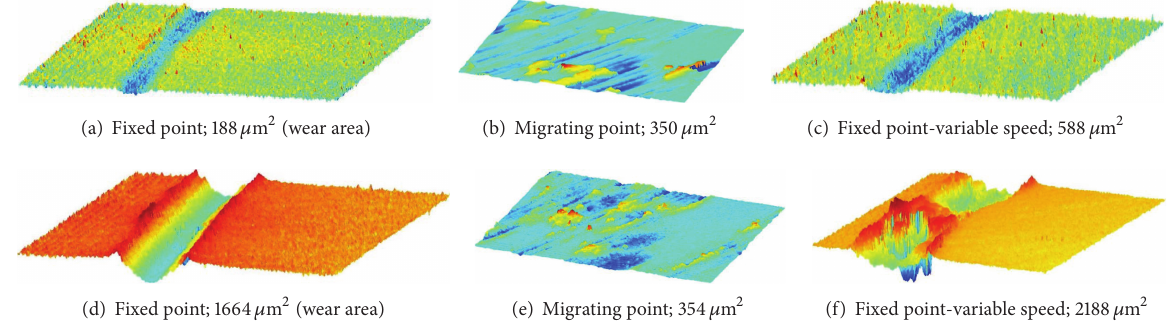
Figure 5: Surface topography of the wear tracks on the disk lubricated by glycerol or glycerol-water mixture. (a, d) fixed point condition and circular geometry, (b, e) migrating point condition and spiral geometry, and (c, f) fixed point-variable speed condition and circular